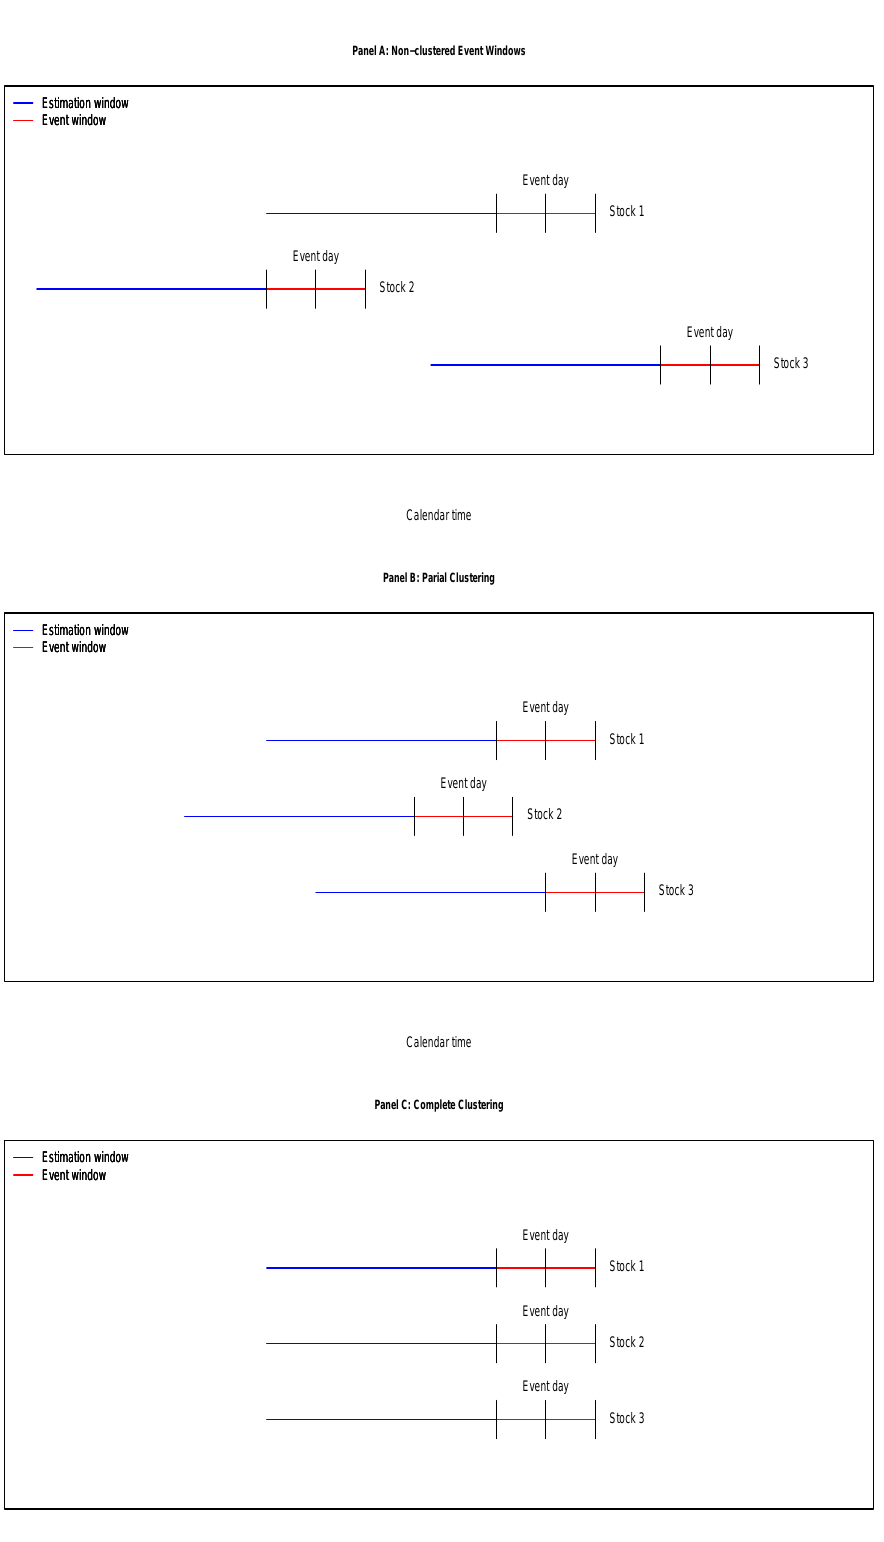
Figure 1. Event Windows